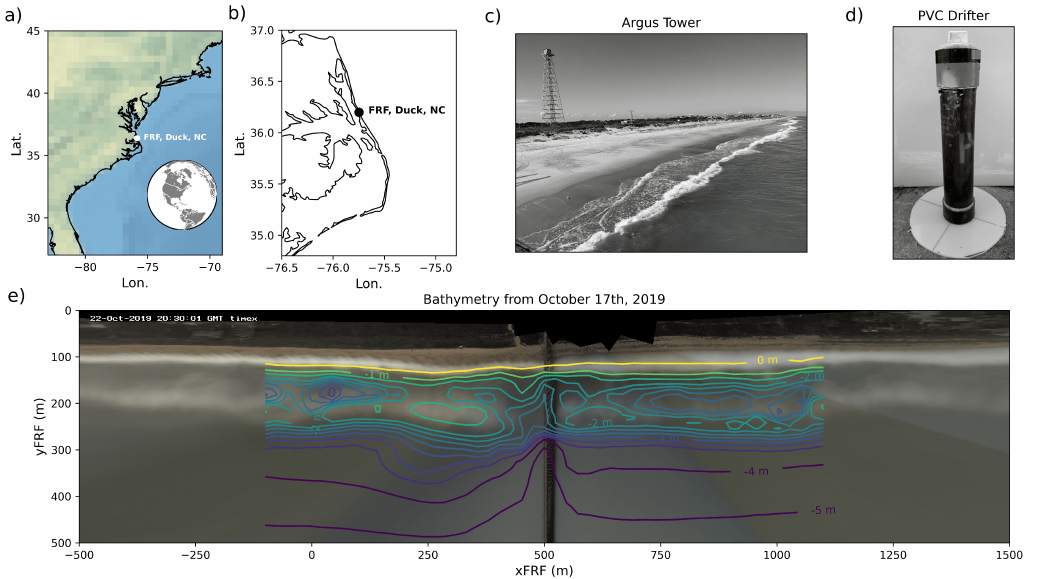
Figure 1. The field research facility is located ( a ) on the western side of the Atlantic Ocean on a barrier island ( b ) in Northern North Carolina with a general shoreline orientation 18 degrees west of north-south. The Argus Tower is located just north of the Field Research Facility (FRF) pier in local reference frame coordinates xFRF = 500 m (( c ), picture taken from pier looking north). PVC drifter hulls ( d ) were thrown into the water from the pier in front of the Argus Tower and allowed to float freely. Images from six cameras were merged to yeild rectified maps of the entire FRF property and extending offshore more than 500 m on 22 October 2019 ( e ). The most recent bathymetry before drifter deployments is provided as contours on top of a timex image to highlight the alongshore sandbar configuration at ∼ xFRF = 200